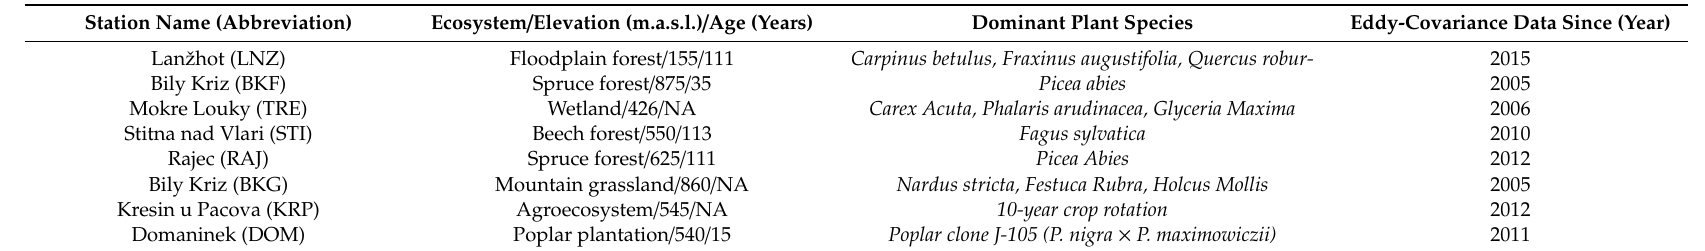
Table 1. Ecosystem stations included into the CzeCOS (ICOS) research